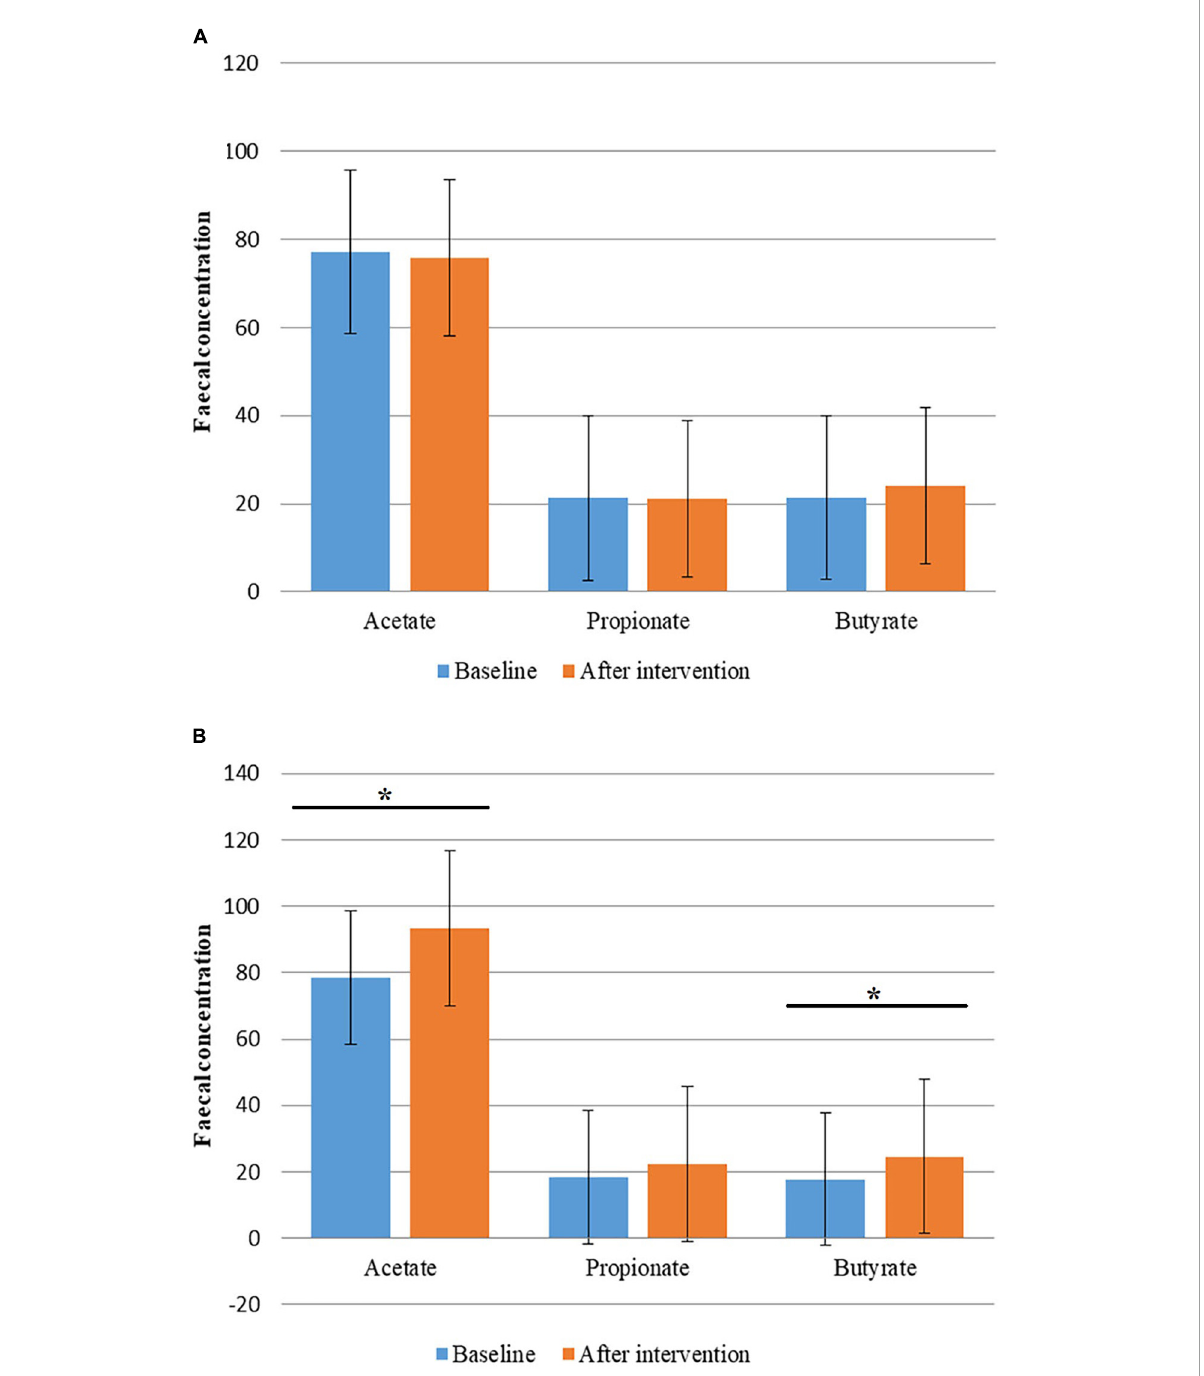
FIGURE3 Fecal concentration of short chain fatty acids (SCFAs) before and after intervention in obese women. (A) Fecal concentration of SCFAs before and after Allium intake. (B) Fecal concentration of SCFAs before and after placebo intake. Comparisons were done using paired samples t -test or Wilcoxon test. *Significant difference within groups. * P -value <